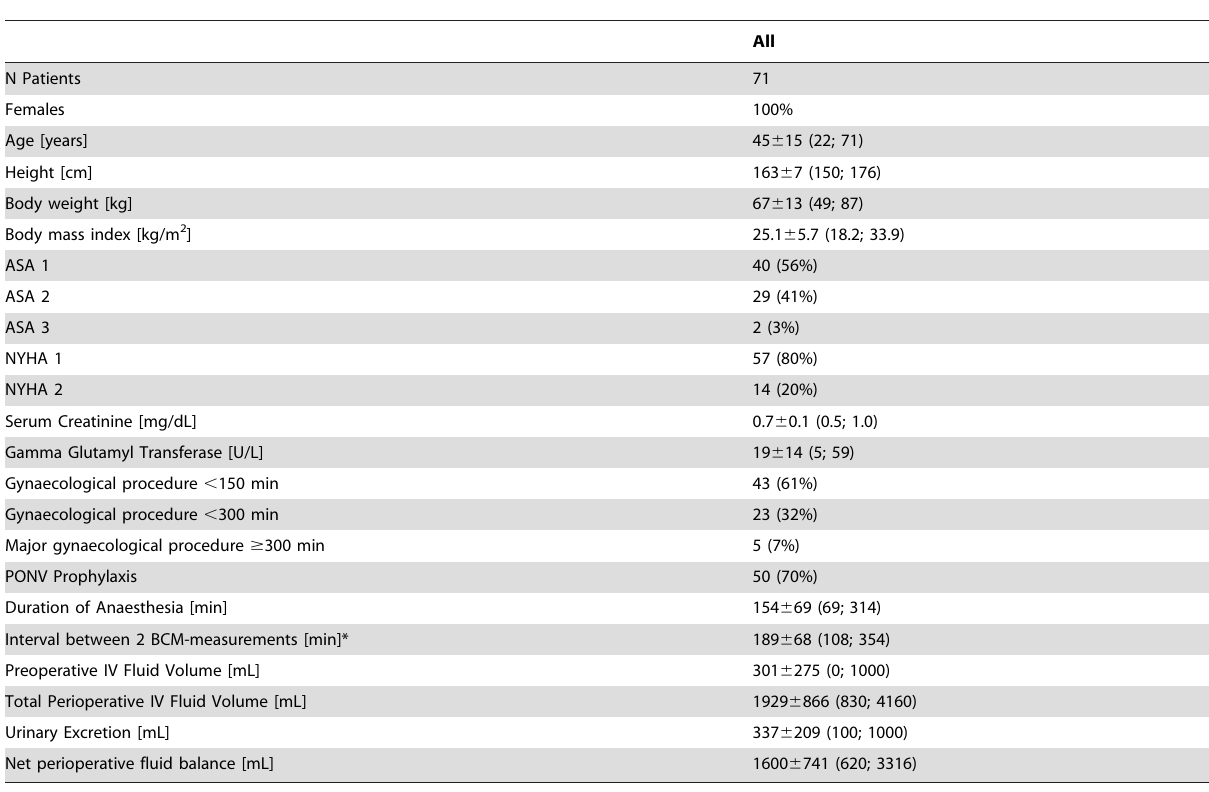
Table 1. Demographic characteristics of the study population.